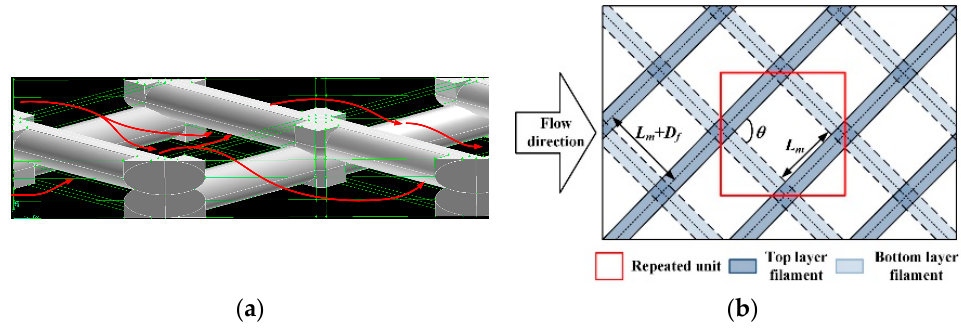
Figure 3. The flow paths ( a ) and geometric characteristics ( b ) of the net-type spacers.